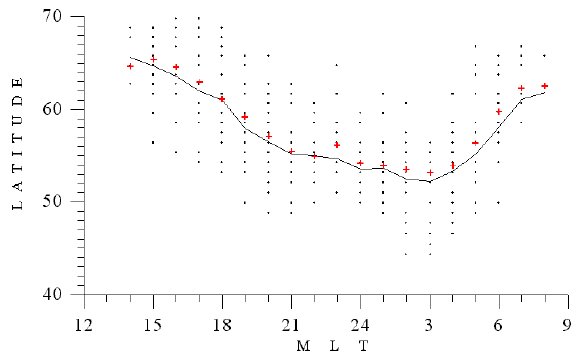
Fig. 7 Position of the trough minimum for October 1999 (in CGL and MLT). Dots – daily values, Fig. 7. Position of the trough minimum for October 1999 (in CGL crosses – monthly averages, black line – approximation and MLT). Dots – daily values, crosses – monthly averages, black line –